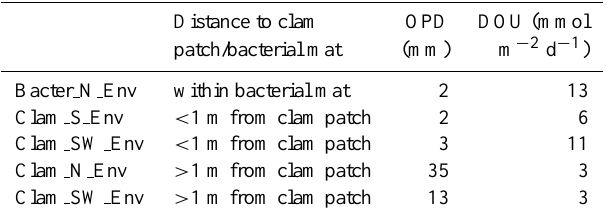
Table 3. Sediment oxygen penetration depth (OPD) and diffusive oxygen uptake (DOU) of sediments in relation to the vicinity of clam patches and bacterial mat at REGAB, as measured in situ with a microprofiler.